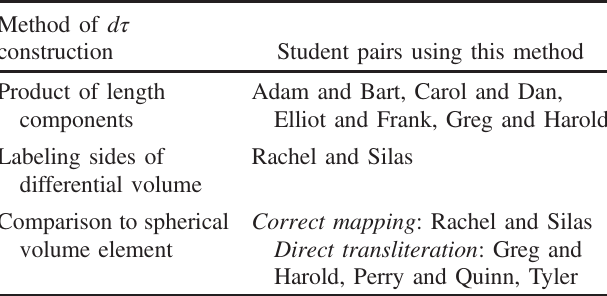
TABLE III. List of methods used by students to determine the differential volume element and groups having used each method.